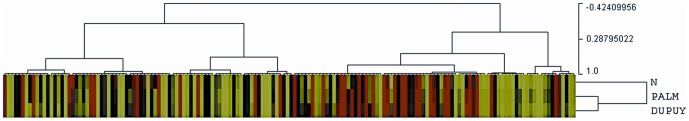
Unsupervised hierarchical cluster analysis of the different samples included in the present study.Overexpressed genes are shown in green and downregulated genes are shown in red. The classification tree of the samples is displayed at the right side of the figure. N: normal forehand fascia (NFF); Palm: palmar fascia clinically unaffected by Dupuytren's disease contracture (NPF); Dupuy: Dupuytren's diseased contracture cords (DDC).